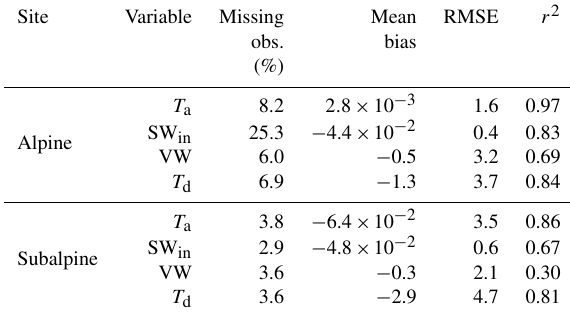
Table A1. Cross-validation statistics for the multi-station regression infilling procedure for air temperature ( T a , ◦ C), total incoming solar radiation (SW in , MJm − 2 ), wind speed (VW, ms − 1 ), and dew point temperature ( T d , ◦ C). Note: relative humidity values were converted to T d for computing the multi-station regression. Site Variable